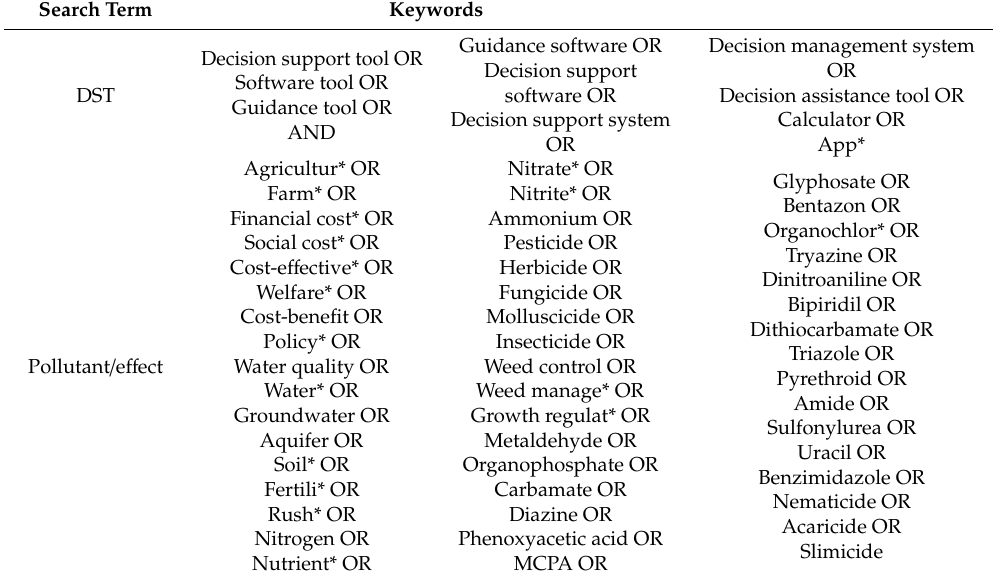
Table A1. Keywords used for the online literature search (Web of Science).